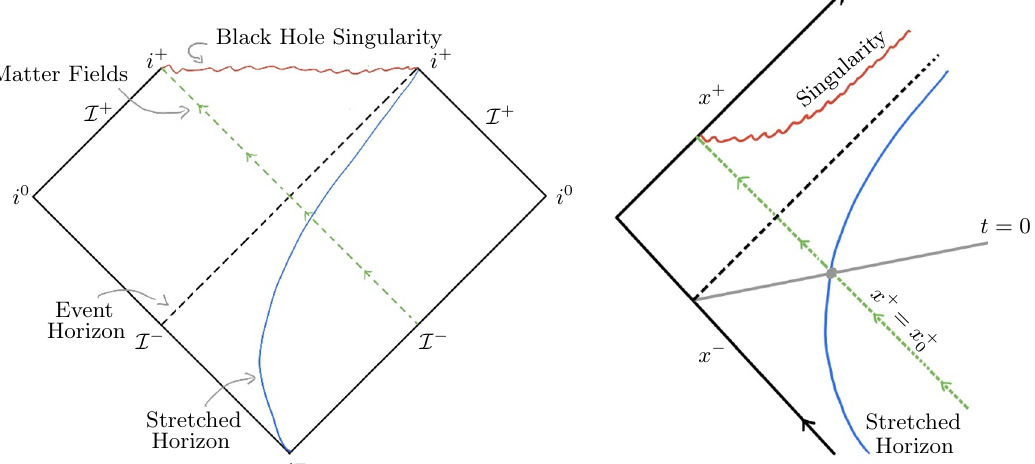
Figure 1 . Left panel: Penrose diagram of one-sided CGHS black hole formed by gravitational collapse. Right panel: the corresponding Kruskal diagram with the same color coding. The gray line denotes a curve of equal tortoise time t